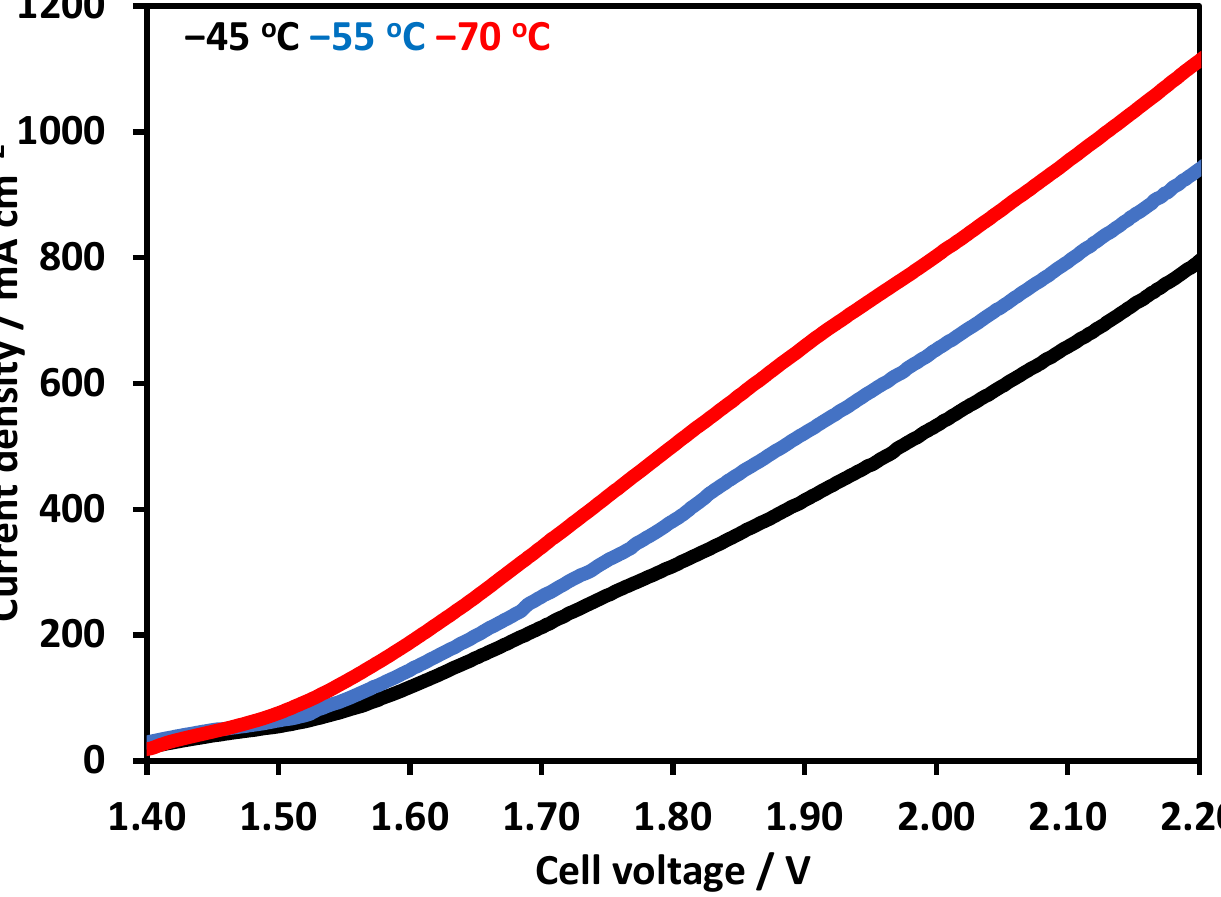
Figure 6. Linear Sweep Voltammetry at temperature range of 45 to 70 °C. Pt/C was used at cathode and synthesized NiFeCoO x was used at anode. FAA-3-50 membrane with a thickness of 50 µm was used in electrolysis operation.